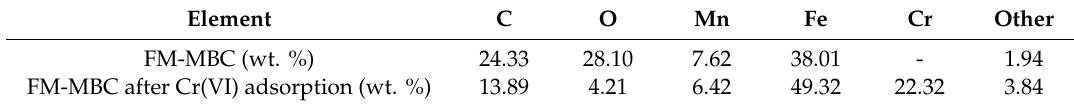
Table 3. Surface composition of the FM-MBC and FM-MBC after Cr(VI) adsorption by EDS analysis. Element C O Mn Fe Cr Other FM-MBC (wt. %) 24.33 28.10 1.94 FM-MBC after Cr(VI) adsorption (wt.